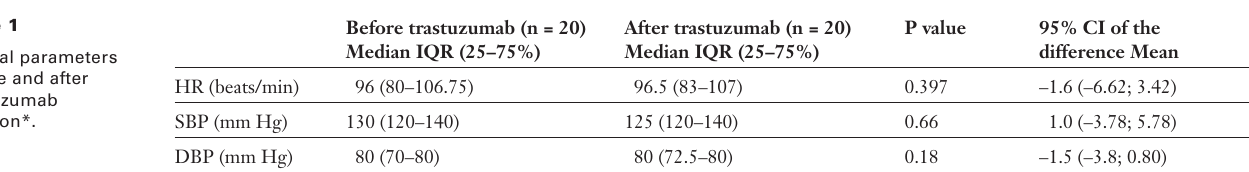
ECG parameters be- fore and after trastuzumab infu-